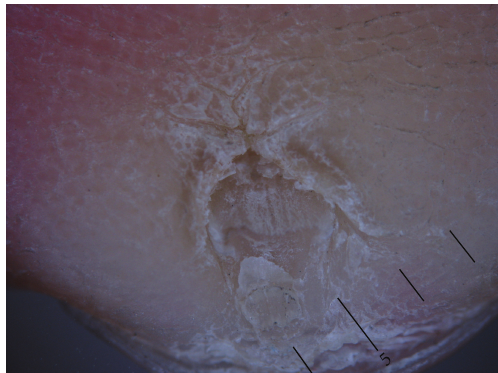
Figure 1: A diagram of the nail apparatus. The nail isthmus is present in the transitional zone between the most digital part of the nail bed and the hyponychium.